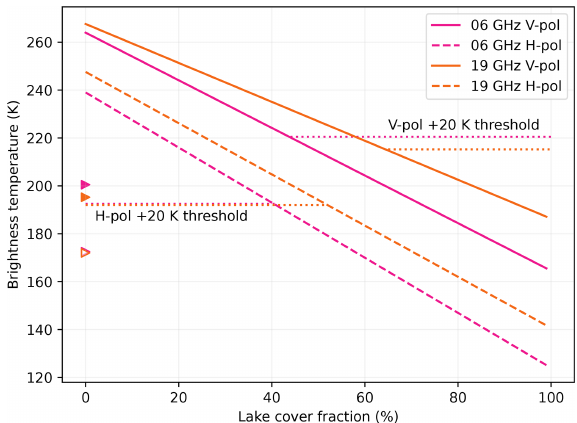
Figure 16. Brightness temperature of a mixed pixel as a function of lake cover fraction (the remaining area is covered by wet snowpack; 10cm thick snow with 15kgm − 2 of total water content). The dry winter brightness temperatures are indicated (triangles) as well as the thresholds of melt detection (dotted horizontal lines). Note that the H-pol thresholds are very close at both frequencies, with the lines almost